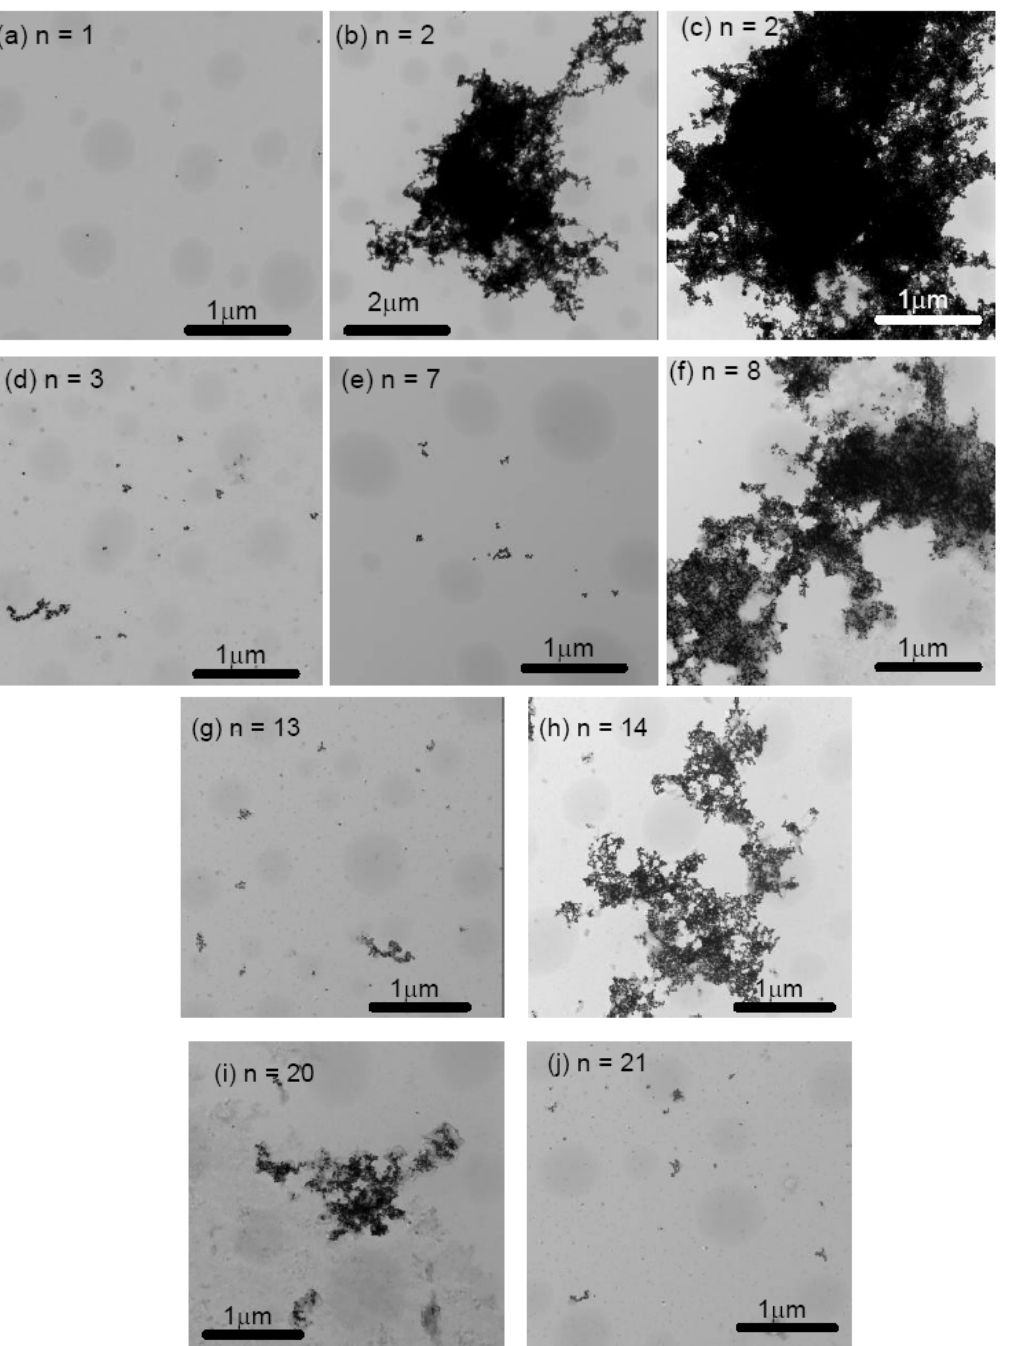
coated 20 nm gold colloids (a) n = 1 (pH 7), Figure 11. The TEM images of A  1-40 (b) n = 2 (pH 4), (c) n = 2 (pH 4), (d) n = 3 (pH 10), (e) n = 7 (pH 10), (f) n = 8 (pH 4), (g)